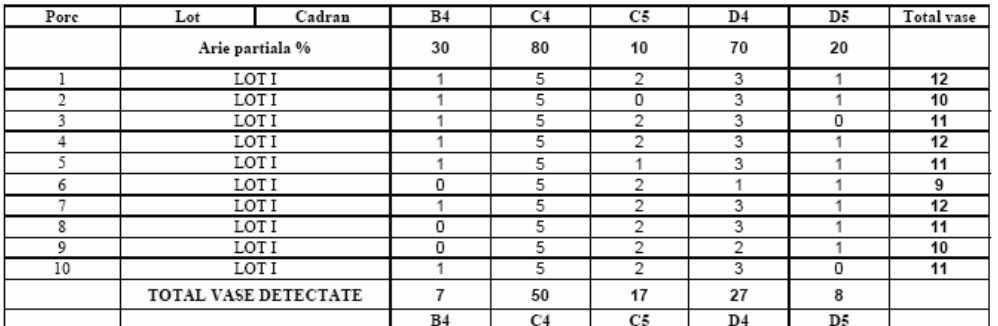
Table 1. Example of data centralization table showing the number of perforator vessels identified by vascular preoperative imaging and the topographic quadrant (in the lumbar paravertebral